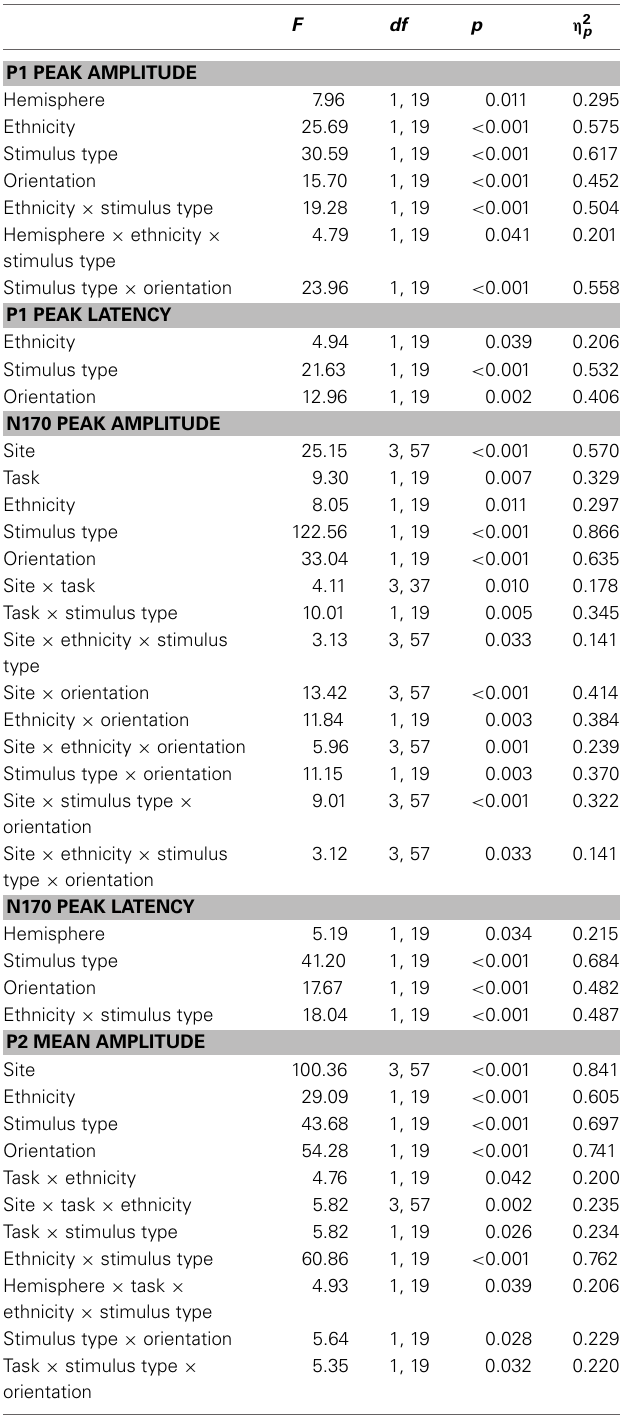
Table 2 | Significant effects of omnibus ANOVAs on ERP